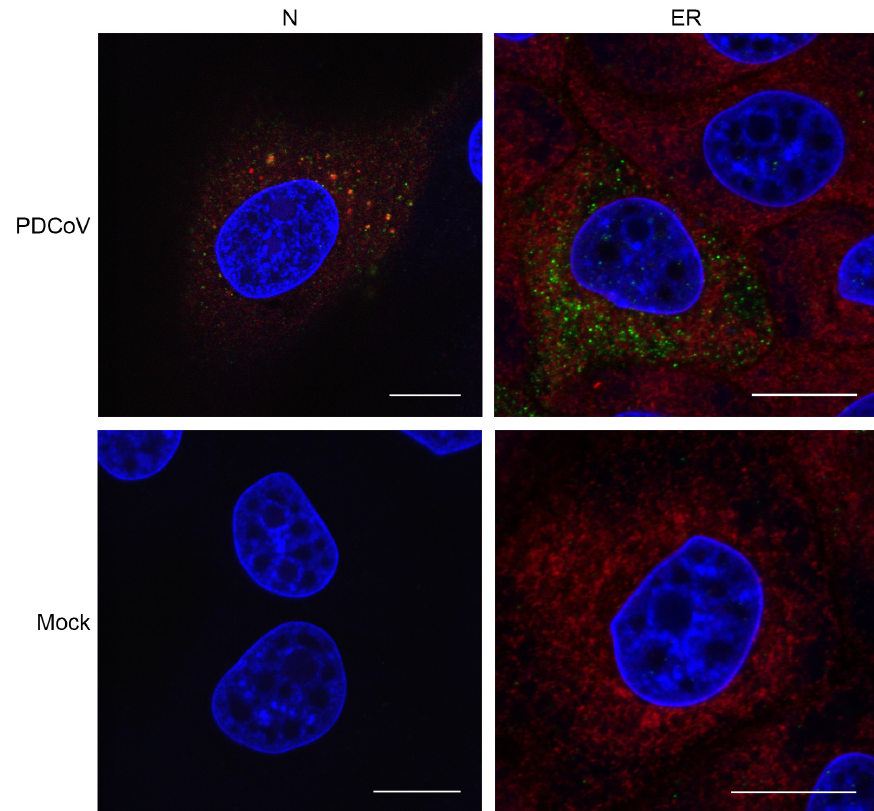
Figure 4. Sites of PDCoV RNA synthesis were associated with viral N protein, but not the endoplasmic reticulum (ER). LLC-PK1 cells were infected or mock-infected. Thirty minutes prior to fixation, cells were incubated with 2 mM 5-Bromouridine (BrU) and 15 µ M actinomycin D. Cells were fixed and labelled with anti-BrdU (green) and either anti-N or anti-ER antibodies (red). Nuclei were stained with DAPI (blue), scale bar indicates 10 μ m.